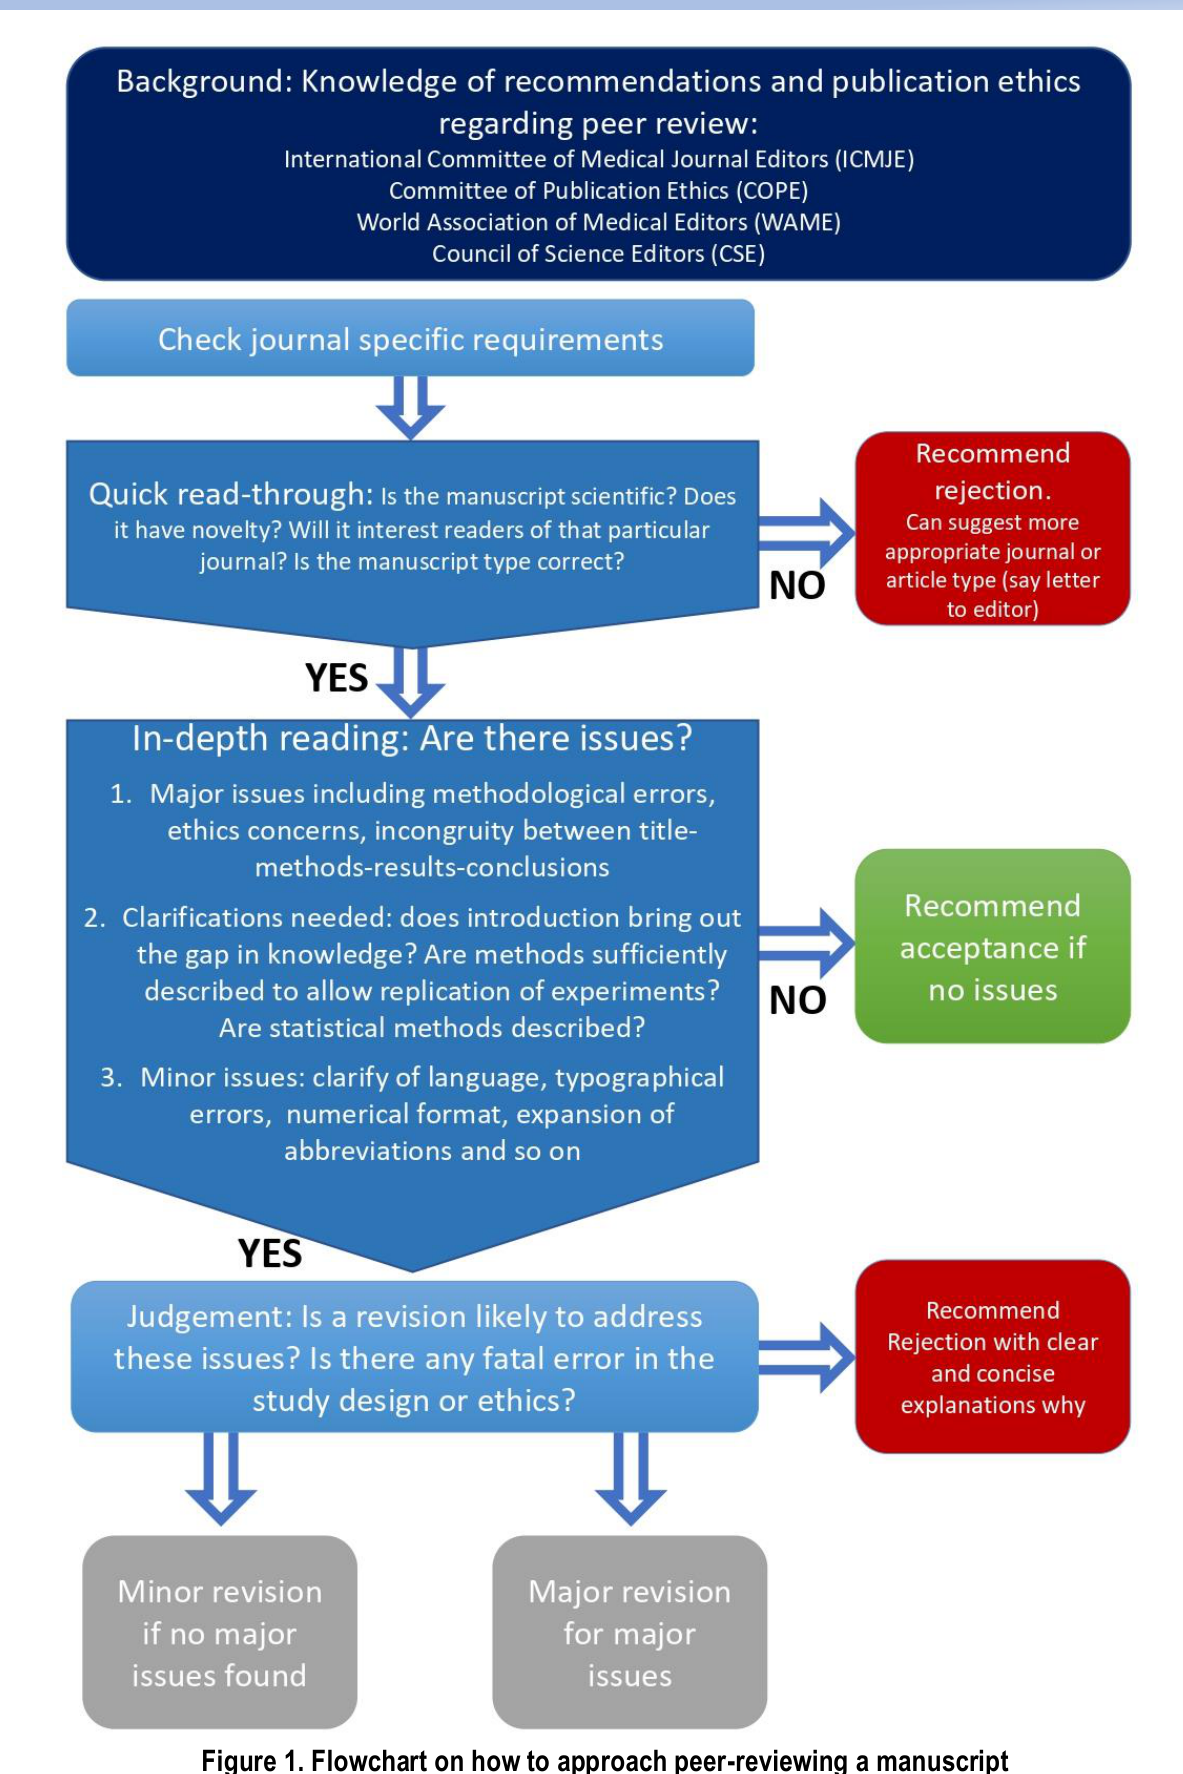
Figure 1. Flowchart on how to approach peer-reviewing a